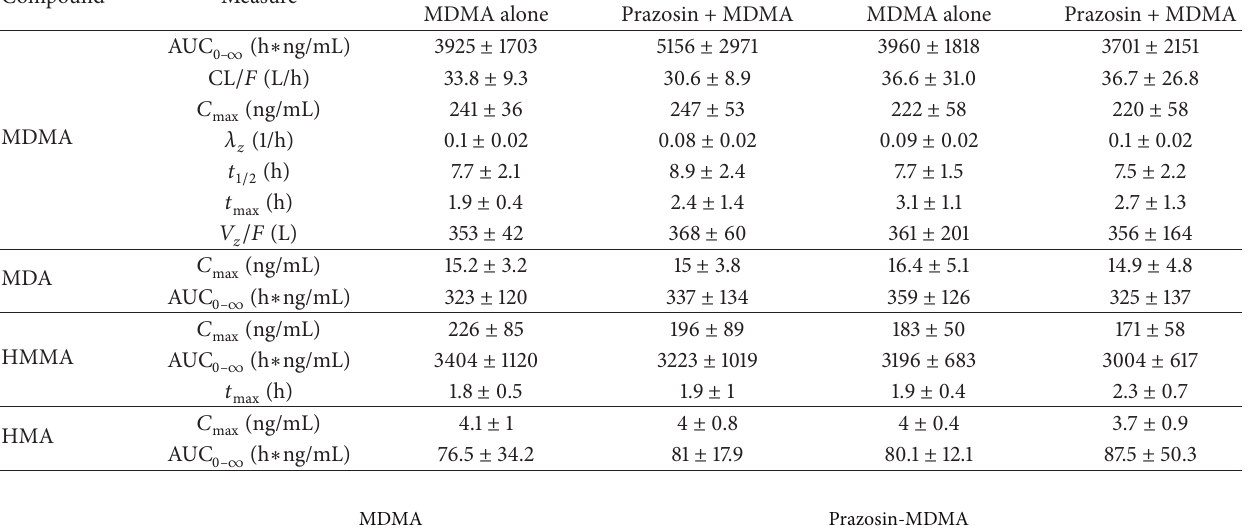
:areaunderthecurvefrom0toextrapolatedtoinfinity, – ∞